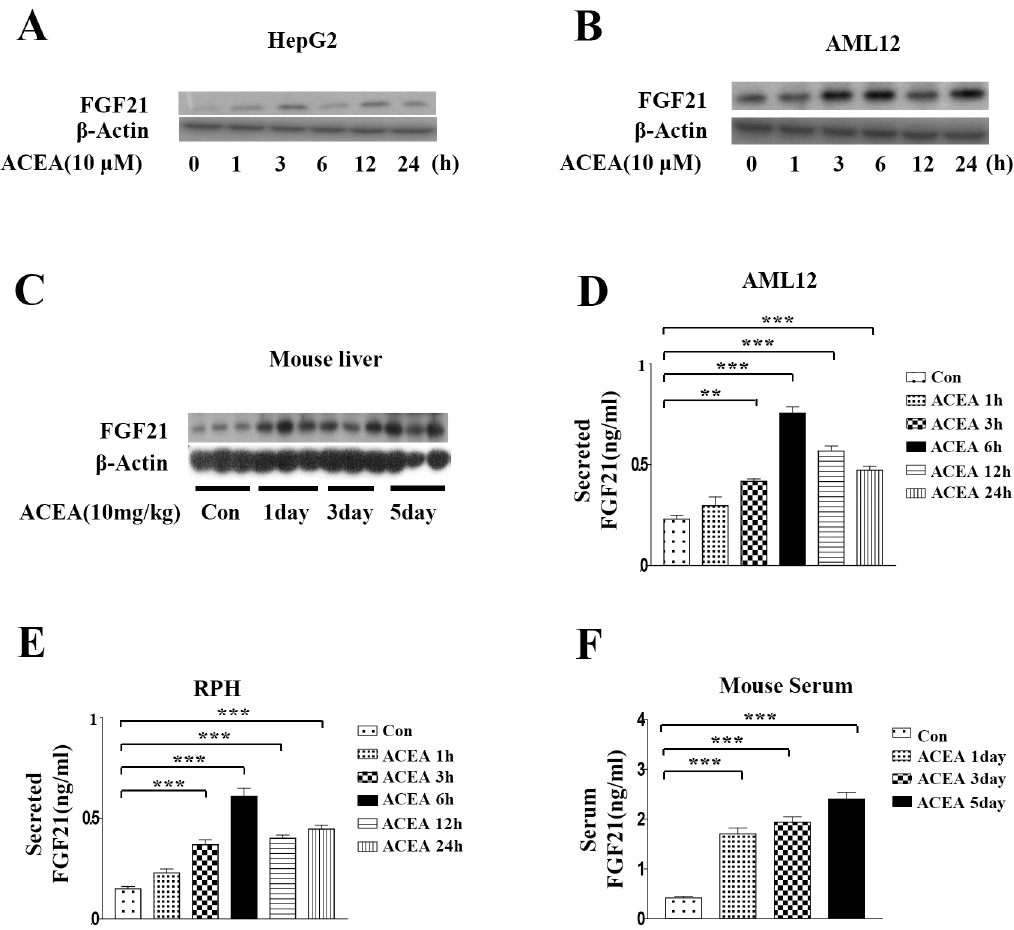
Fig 2. ACEA increases FGF21 protein levels. (A – C) Whole cell lysates of ACEA-treated HepG2 cells and AML12 cells and livers of ACEA-treated intact mice were harvested for western blot analysis. (D – E) AML12 cells and rat primary hepatocytes were treated with ACEA (10 μ M) for the indicated time periods. Culture media were collected for FGF21 secretion analysis. (F) Mice were treated with ACEA (10 mg/kg) for the indicated number of days. Serum was obtained for FGF21 secretion analysis. All data are the means ± standard errors of at least three independent experiments. ** p < 0.01; *** p < 0.001 by one-way